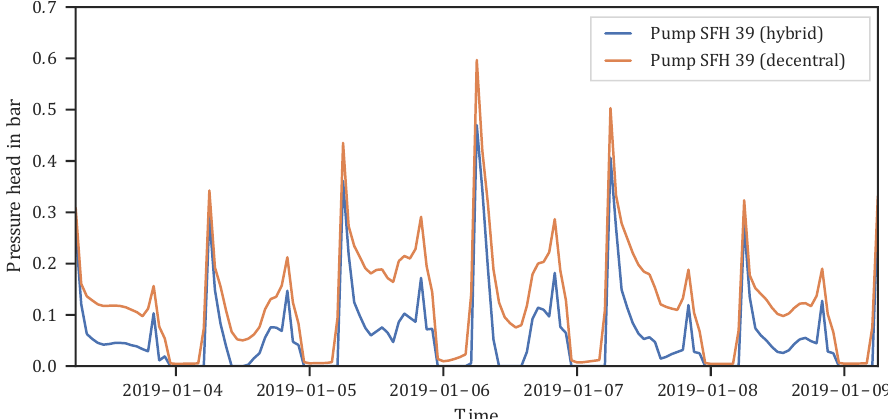
Figure 11. Comparison of the pressure difference of the decentralized pump at the most peripheral substation.